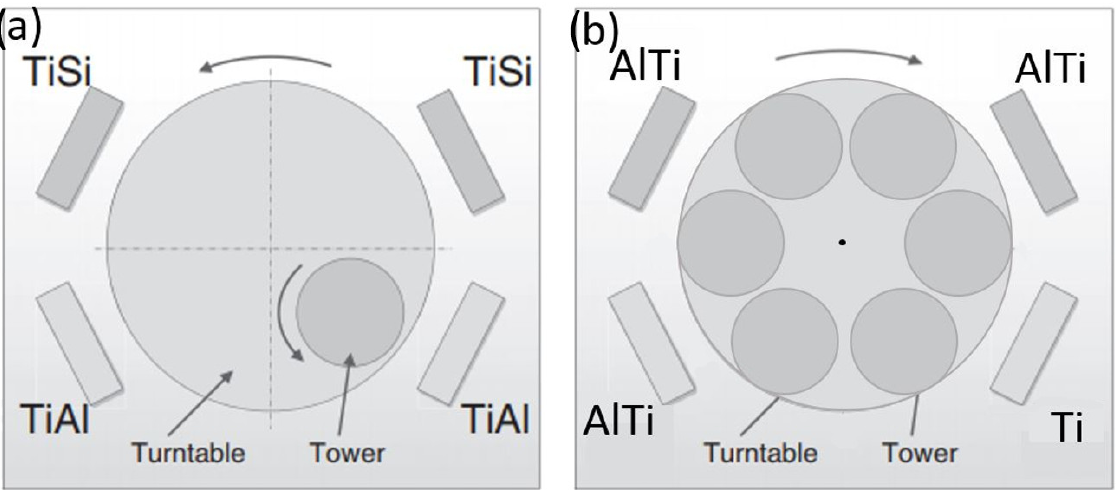
Figure 2. Cross-sectional TEM image of nanocomposite TiSiN and nanolayer TiAlSiN layers in »TiAlSiN« hard coating [27].